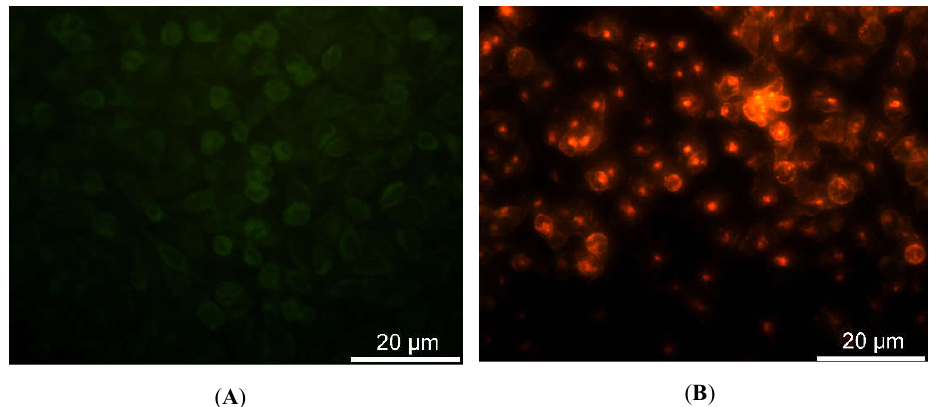
Figure 8. Uptake of Ru(bpy) 32+ in epithelial cells of colon adenocarcinoma, observed by fluorescence microscopy: Intrinsic green fluorescence of LoVo controls ( A ) and red fluorescence of samples treated with 0.4 μM of fluorophore ( B ), after 24 h labeling, with a high density in the cells central region. Fluorescence was acquired with a 488 nm light source and collected at 620–630 nm.